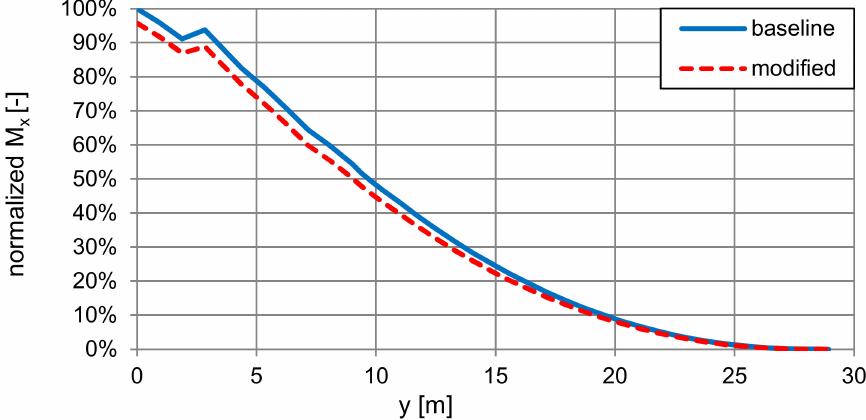
Figure 11. Normalized maximum bending moment (M x ) over the span, comparison of the two variants.